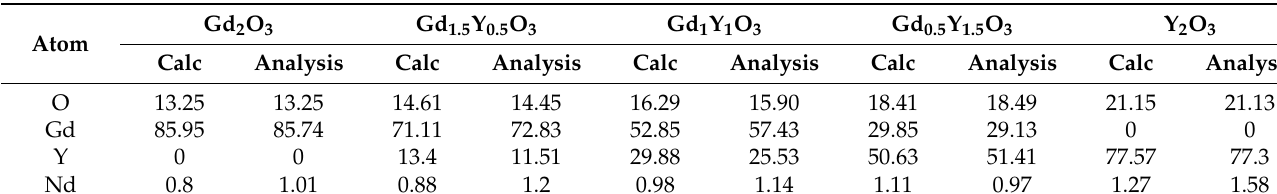
Table 2. The chemical composition of (Gd 1 − x Y x ) 2 O 3 crystalline powders (wt.%).